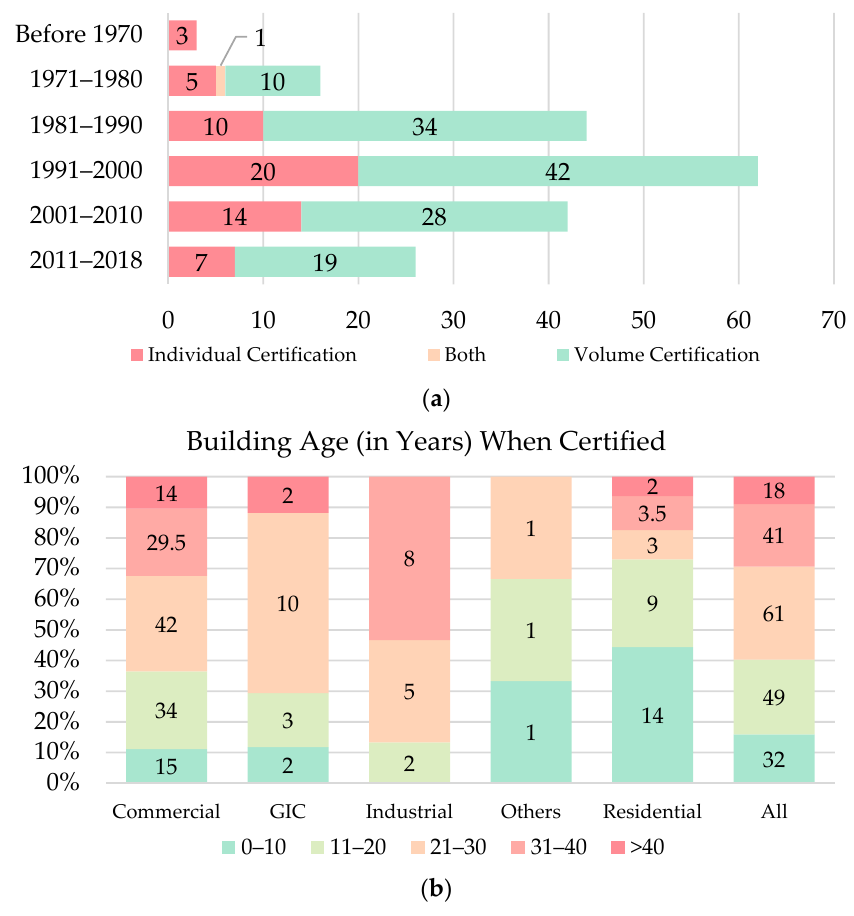
Figure 3. ( a ) Project by completion year; ( b ) building age when certified by project types.